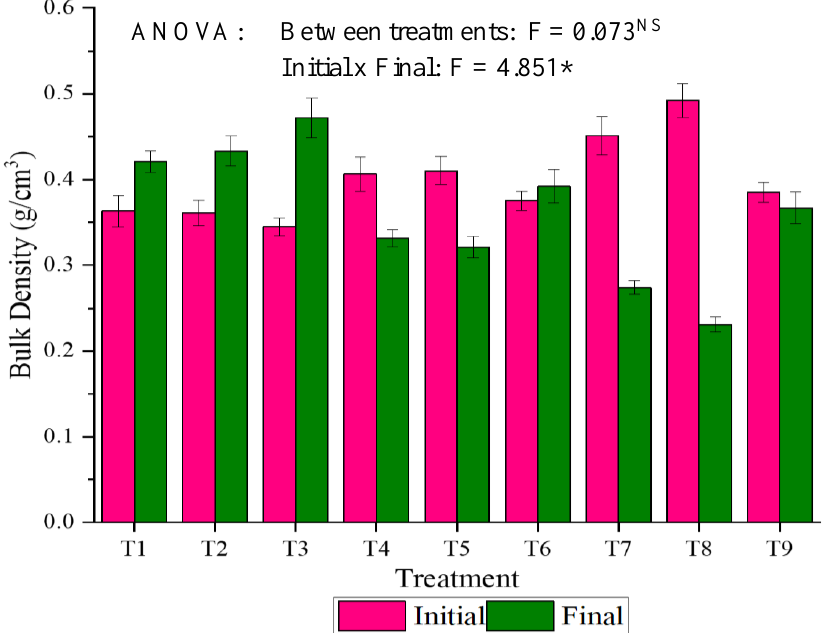
Figure 4. Profile of bulk density variations among different composting treatment groups. ‘*’ indicates significance of difference and ‘NS’ indicates ‘non-significant difference’ at p < 0.05 by ANOVA. The total porosity percentage of the composting mixtures was found to be inversely proportional to their BD. As observed in other parameters, the porosity was also affected by the concentration of food waste used in a composting mixture. Similarly, the biochar amendment influenced the composting process in a desirable way by increasing the final total porosity. The porosity percentages were 71.52%, 72.64%, 65.39%, 75.42%, 78.96%, and